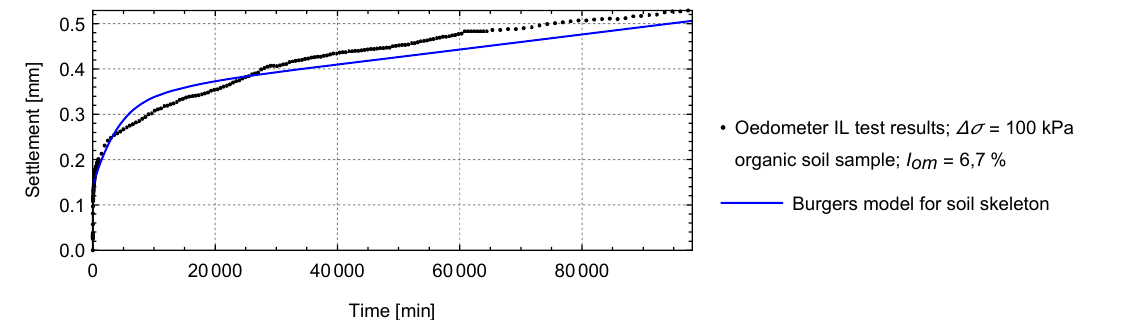
Figure 4. Comparison of the solution with Burgers model with long-term incremental loading (IL) oedometer test